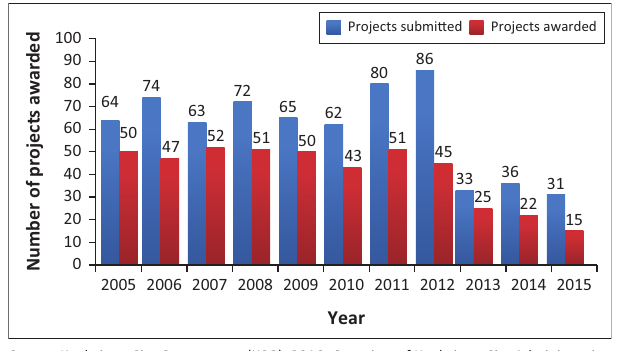
FIGURE 3: Kaohsiung City Government research and development results statistics (2005–2015).